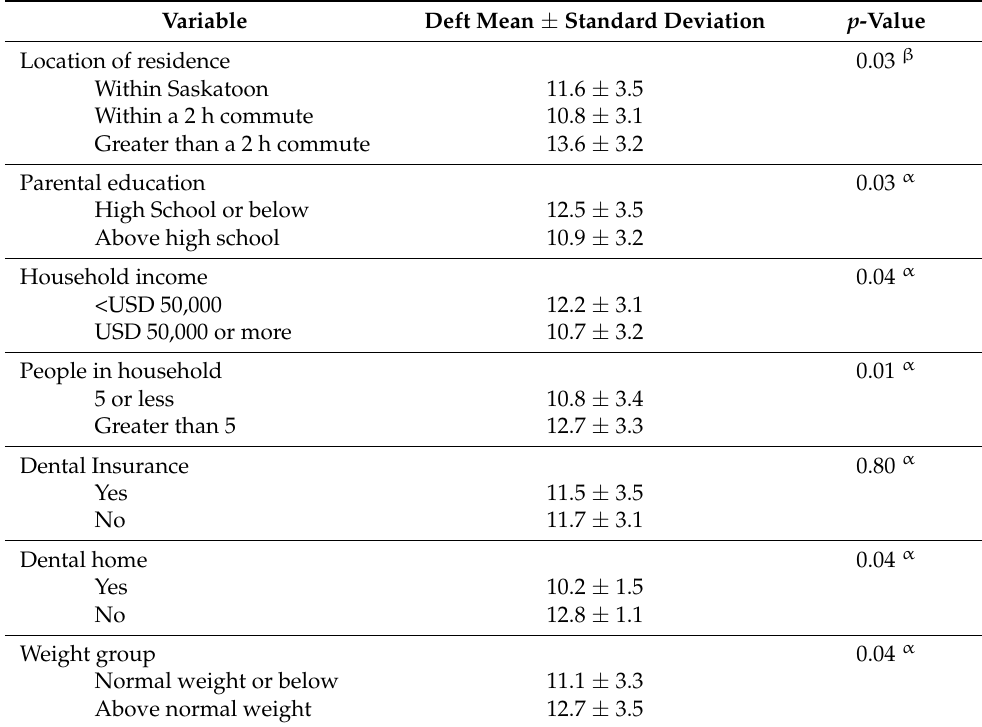
Table 4. Differences in mean deft